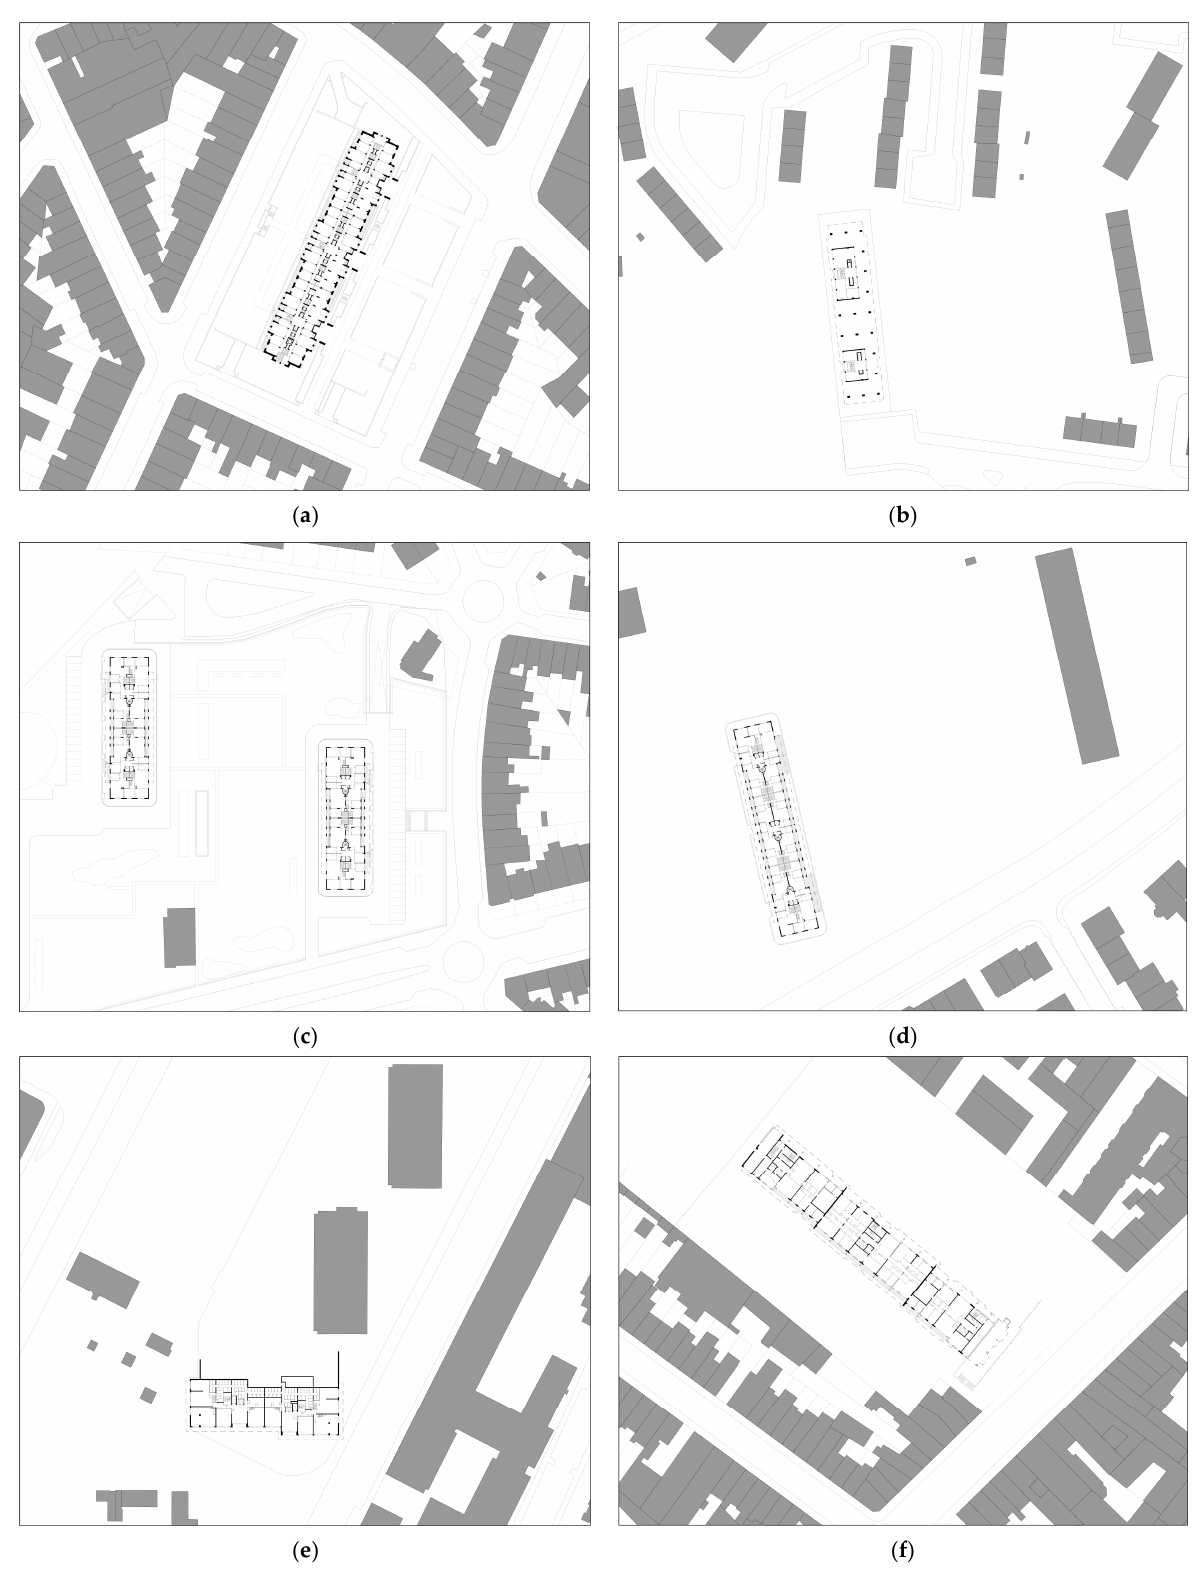
Figure 5. Urban layouts of selected postwar types (re-drawings by the authors): ( a ) Alexis Dumont and Paul Goolaerts, avenue de la Brabançonne 80 (1954); ( b ) Maxime Brunfaut, avenue Auguste Vermeylen 58–60 (1956); ( c ) Groupe Urbanisme, dr è ve du Ch â teau 75–77 (1964); ( d ) Jean-Claude Cahen, rue Th é odor De Cuyper 119–123 (1964); ( e ) Jacques Mignolet, quai du Batelage 1–15 (1971); ( f ) M. Boelens and R. Wasterlain, rue Victor Rauter 30–34